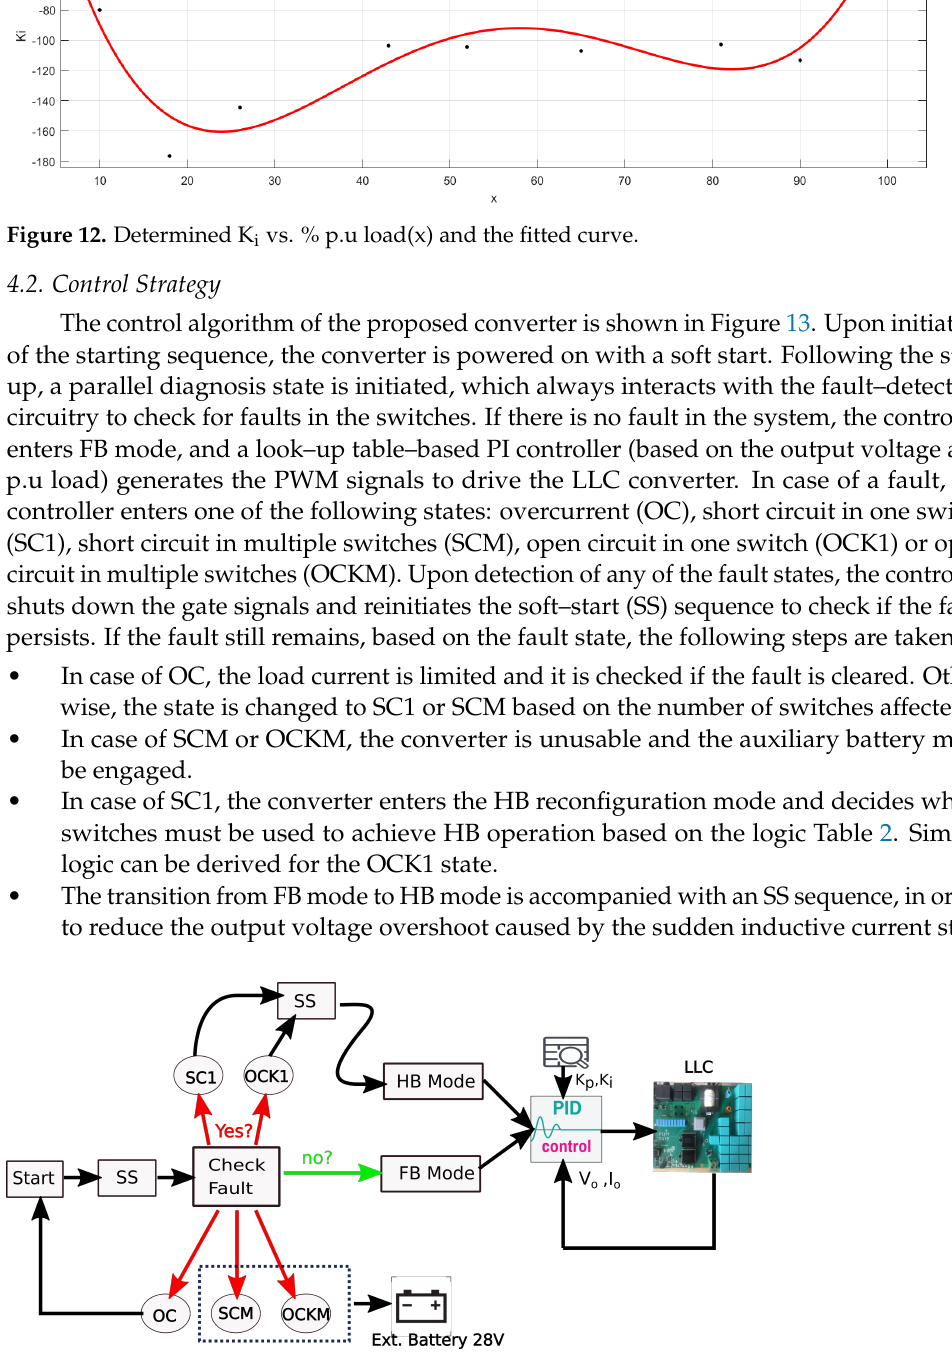
Figure 13. Simplified control logic of the proposed